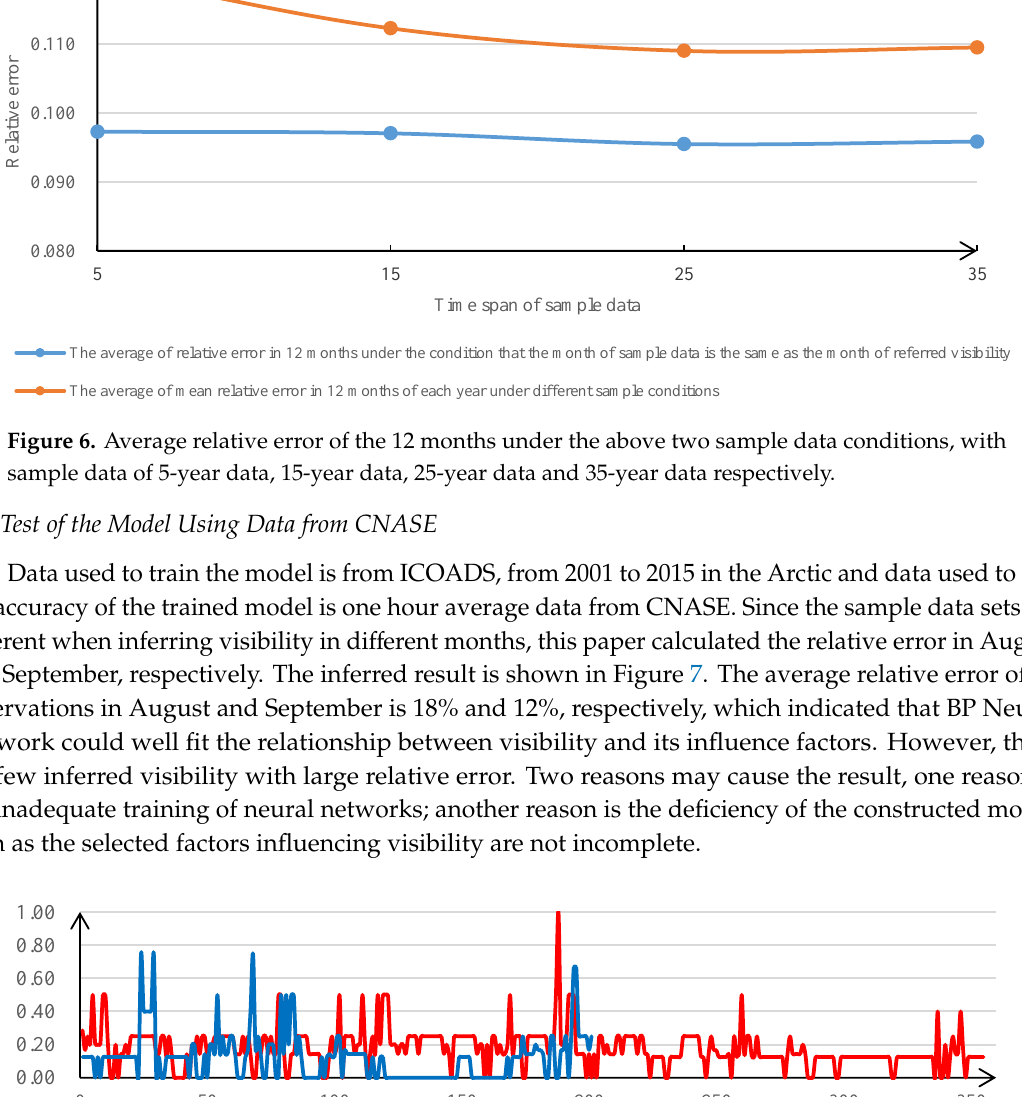
9 of 15 Figure 5. Comparison between the mean relative error of each month under different sample conditions and the relative error under the condition that the month of sample data is the same as the month of referred visibility. 4.2. Effect of Sample Data Quantity on the Accuracy of Referred Visibility By calculating the average relative error of the 12 months under the above two sample data conditions, with sample data of 5-year data (2011–2015), 15-year data (2001–2015), 25-year data (1991– 2015) and 35-year data (1981–2015) respectively, as shown in Figure 6, we can obtain the multi-year